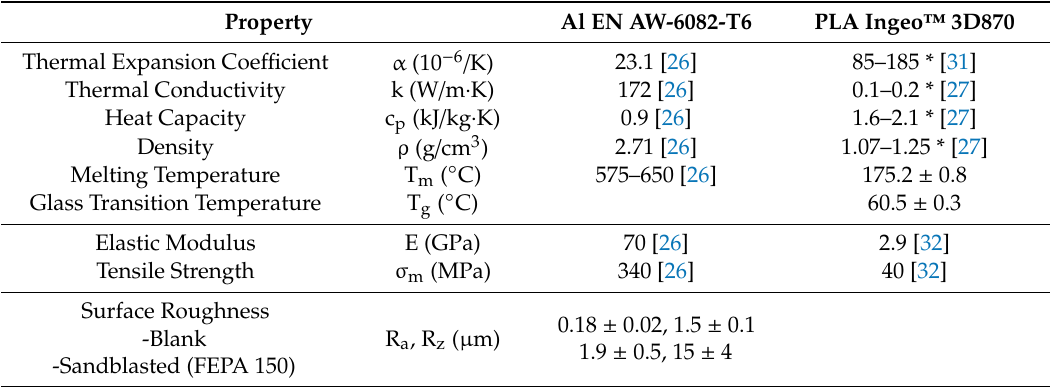
Table 1. Overview of selected thermal and mechanical properties of the materials used. The surface roughness of the aluminum substrates is measured with a Mahr MarTalk profilometer. Values marked with a “*” correspond to a di ff erent type of